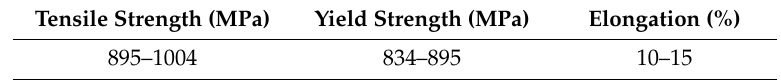
Table 2. Physical properties of TC4 alloy at room temperature, reproduced from [22], with permission